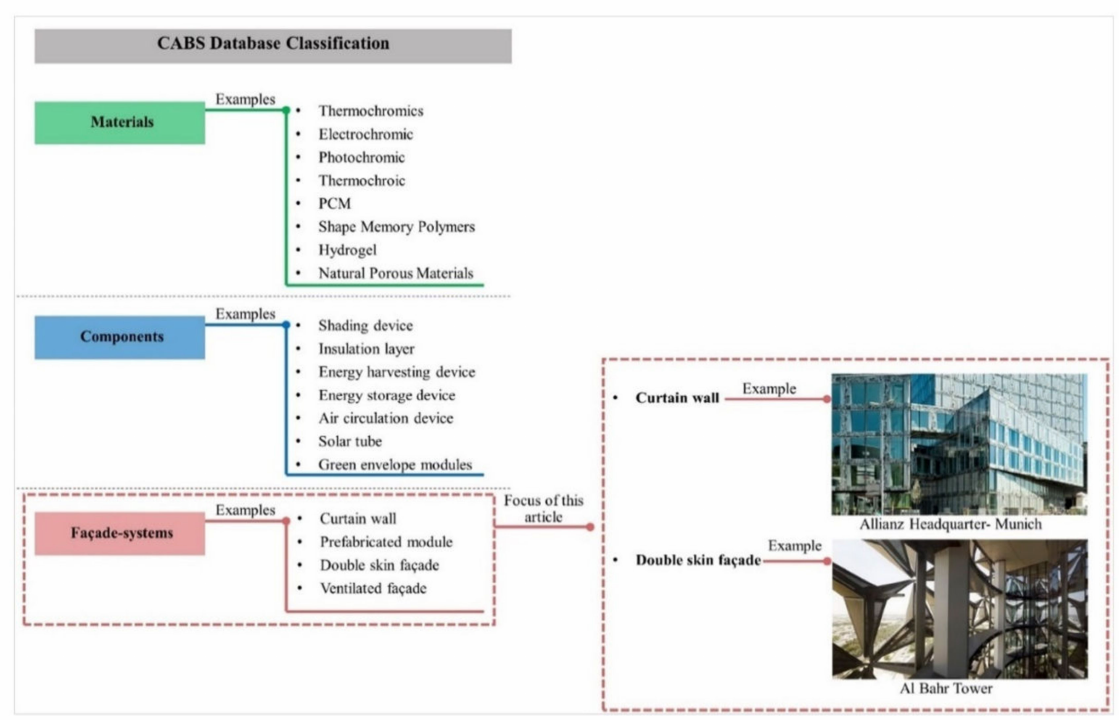
Figure 5. CABS database classification—research focus of this article [30], amended by the au- thors,